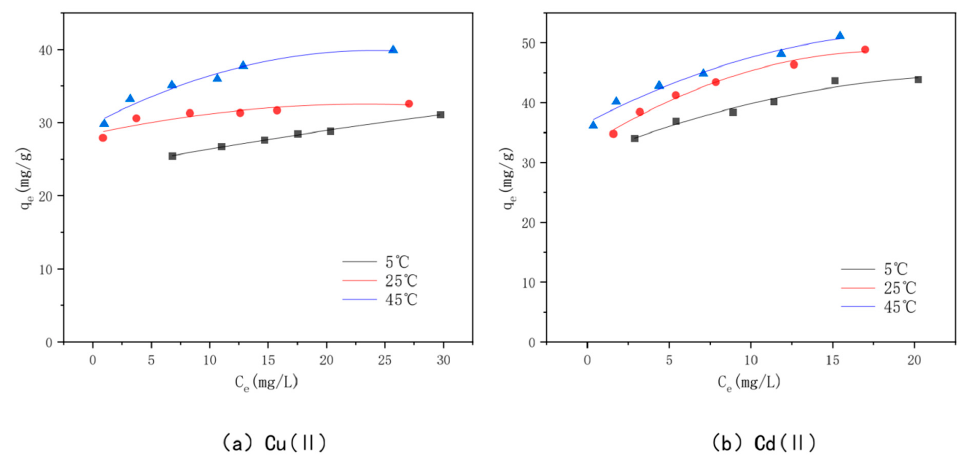
Figure 14. The KAM500-400-3 isothermal adsorption line adsorbing Cu(II)/Cd(II) at different temperatures. Table 7.